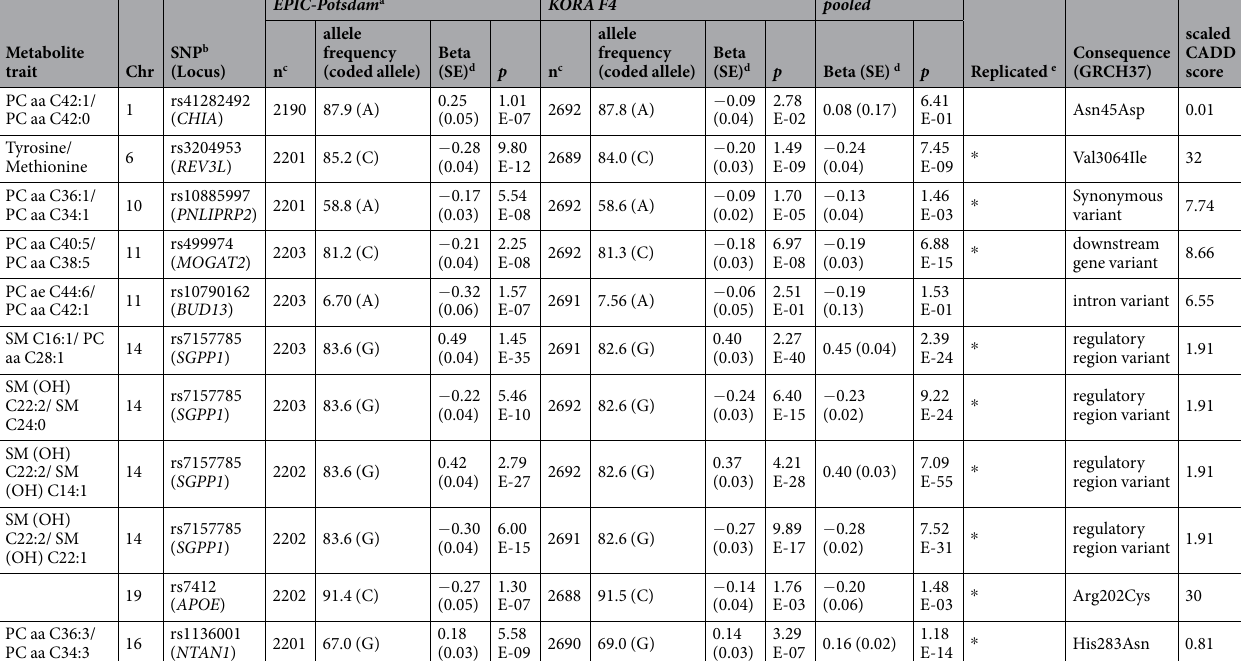
Table 1. Exome chip variants associated with metabolite traits at suggestive significance in EPIC-Potsdam and replication in KORA F4. Chr, chromosome; SE, standard error; CADD, Combined Annotation Dependent Depletion. a only sub-cohort; b gene variants are reported on the forward strand of NCBI build 37; c metabolite outliers ( ± 4SD) were excluded; d metabolites ( µ mol/L) were ln-transformed and standardized, effect estimates are adjusted for age and sex; e significance threshold: 0.05/11 tests = 4.55 × 10 − 3